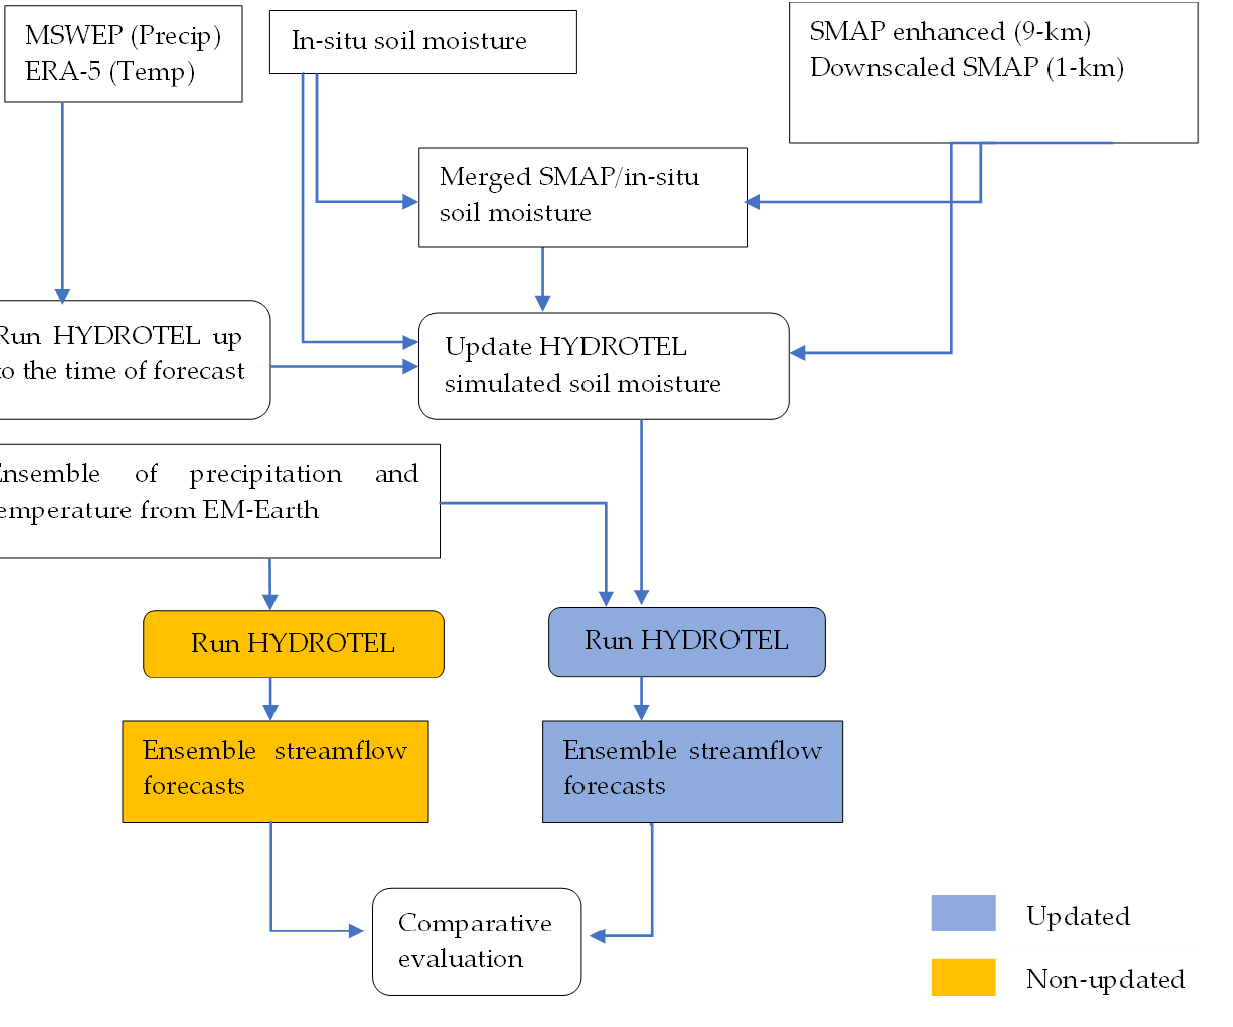
Figure 2. The study framework.